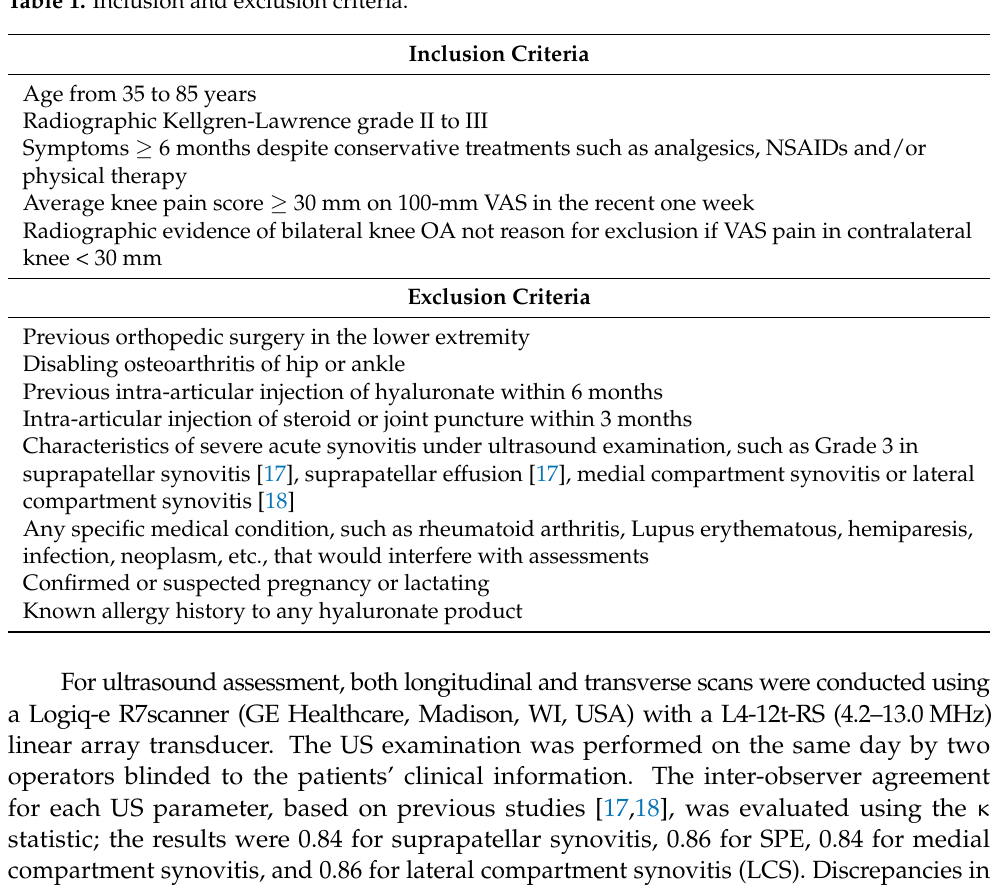
Table 1. Inclusion and exclusion criteria.